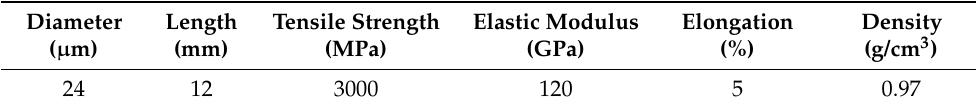
Table 2. Physical and mechanical properties of PE fiber.